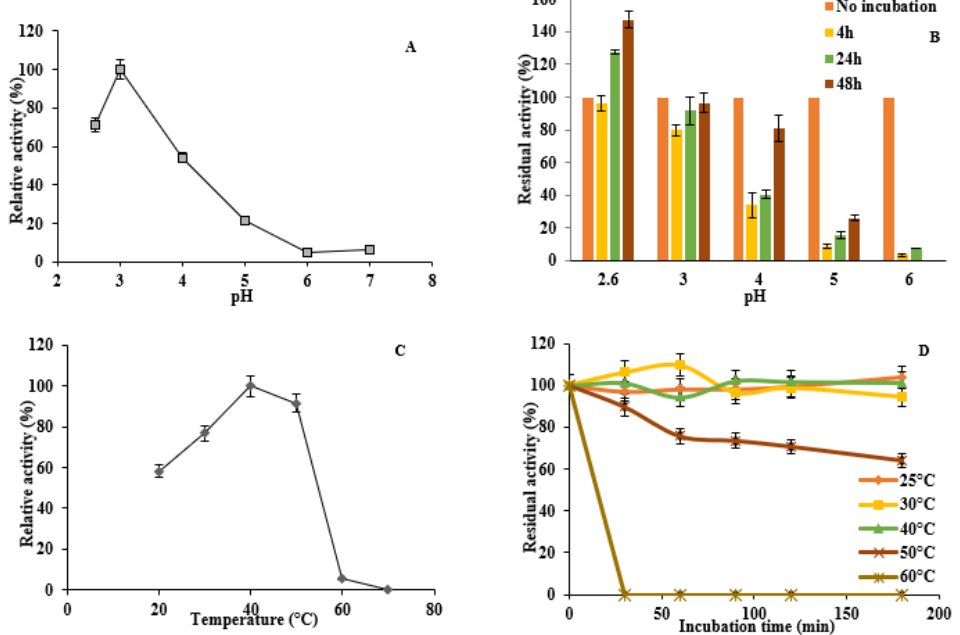
Figure 5. Effect of pH and temperature on enzyme activity and stability. ( A ) Optimal pH for the oxidation of ABTS (5 mM); ( B ) pH stability in the range pH 2.6–6 for 4, 24, and 48 h incubation; ( C ) optimal temperature for the oxidation of ABTS; and ( D ) temperature stability in the range 25–70 ◦ C. Enzyme activity was measured in a 0.1 M citrate-phosphate buffer using ABTS (5 mM) as a reducing substrate and 0.25 mM H 2 O 2 at 30 ◦ C (and at pH 3.0 in ( C , D ). Activity values were calculated as a percentage of maximum activity (set to 100%) at optimum temperature and pH. Each data point (mean +/ − standard deviation) is the result of triplicate experiments.